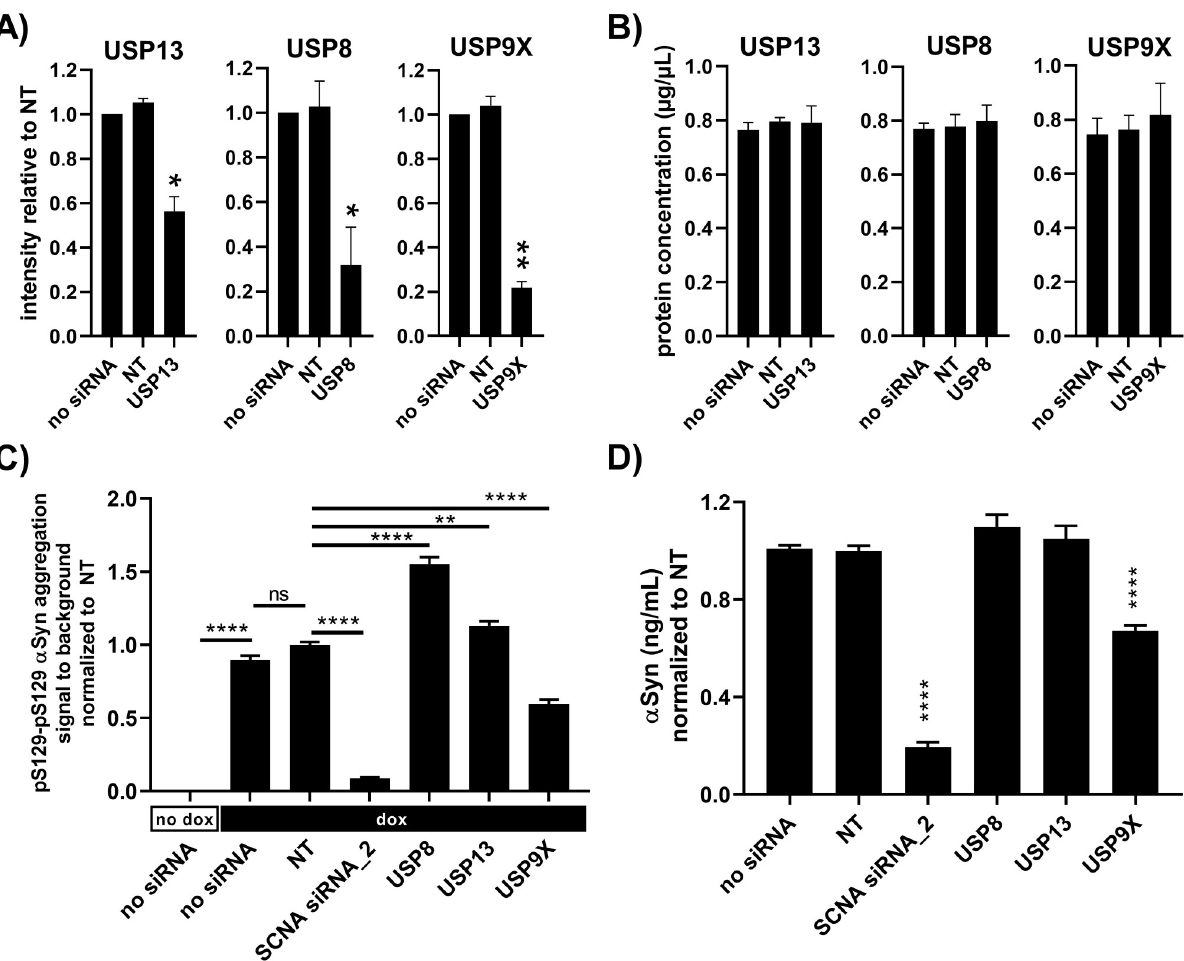
Fig 4. Enzymes of the ubiquitin system affect A53T α -synuclein aggregation. (A) Quantification of western blots (shown in S1 Raw images) showed reduction of USP13, USP8 and USP9X upon addition of specific pools of four siRNAs. The non-targeting (NT) negative control siRNAs were also pools of four siRNAs. (B) Quantification of total protein content in western blot samples showed no significant differences between treatments. (C) All samples were seeded with 0.1 μ g/mL fibrils91. FRET assays for pS129-pS129 α -synuclein aggregation showed increased aggregation in response to USP8 and USP13 siRNAs and decreased aggregation in response to USP9X siRNAs. SCNA siRNAs was included as positive control and non-targeting (NT) siRNAs as negative control. (D) Electrochemiluminescence immunoassay showed down-regulation of α -synuclein protein levels in doxycycline treated neurons in response to SCNA and USP9X siRNAs. Data are shown as mean ± SEM. Data in (A) and (B) were analyzed by one-way ANOVA followed by Dunnett’s multiple comparison test (n = 2, m = 2). Data in (C) and (D) were analyzed by one-way ANOVA followed by Sidaks’s multiple comparison test (n = 3, m = 6). ns = non-significant, � p < 0.05 and �� p < 0.01 and ���� p < 0.0001.